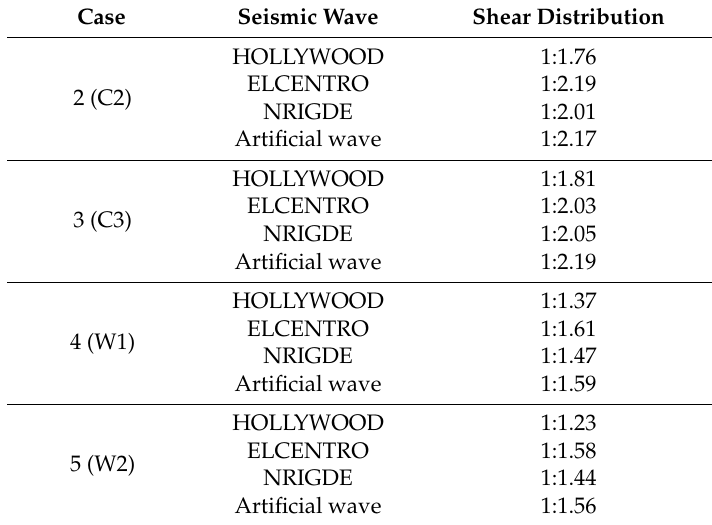
Table 13. Shear distribution in cases 2, 3, 4 and 5.